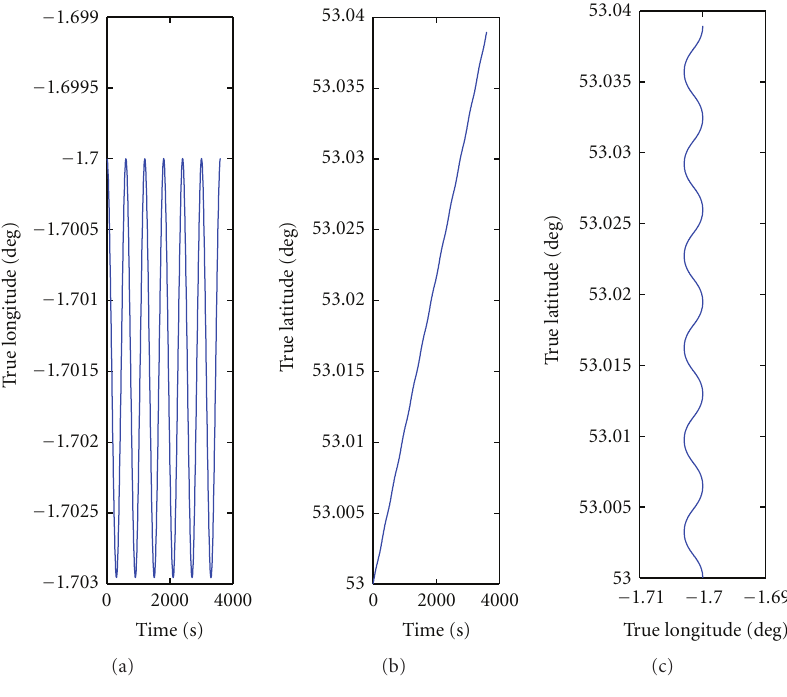
Figure 18: The designed trajectory of s-shape